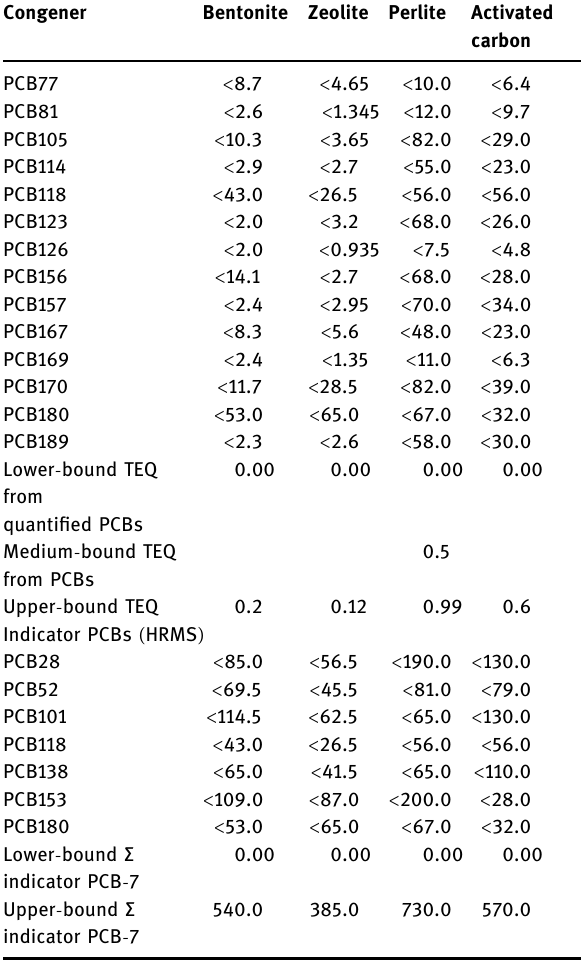
Table 3: Concentrations of PCDDs and PCDFs ( dioxins and furans ) in sorbent samples ( pg/g DW )